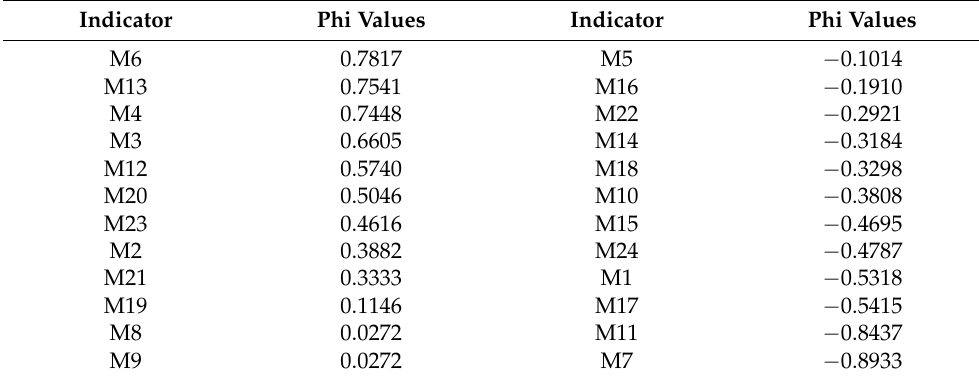
Table 13. PROMETHEE II results for maintenance and repair in healthcare